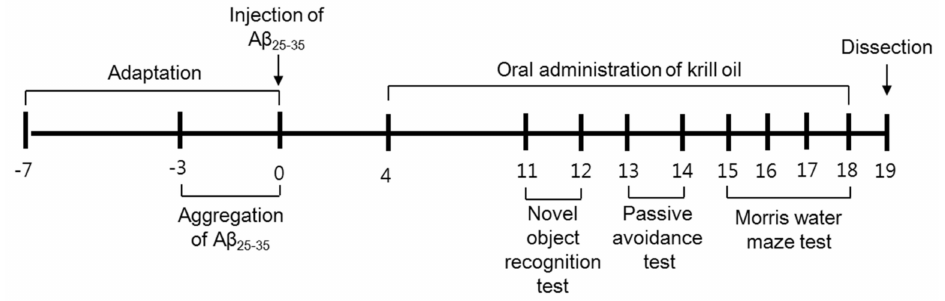
Figure 8. Experimental